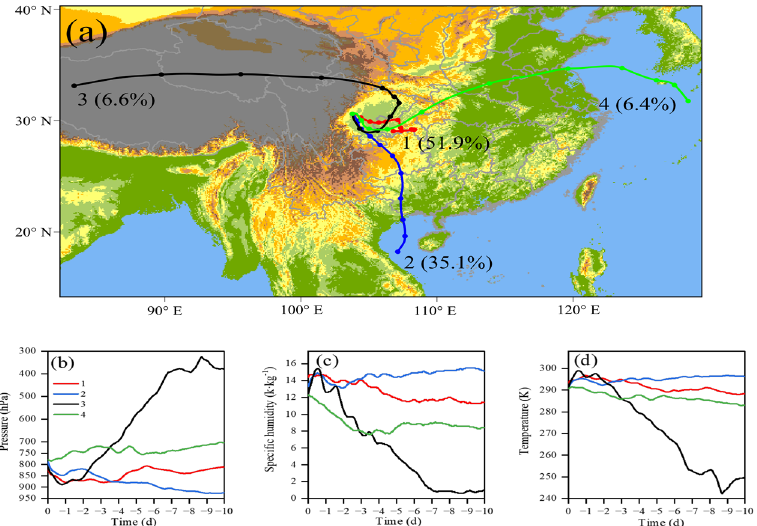
Figure 4. ( a ) Moisture transport paths and temporal variations of ( b ) the air pressure, ( c ) specific humidity, and ( d ) temperature of each path. Paths 1, 2, 3, and 4 are represented by red, blue, black, and green lines.